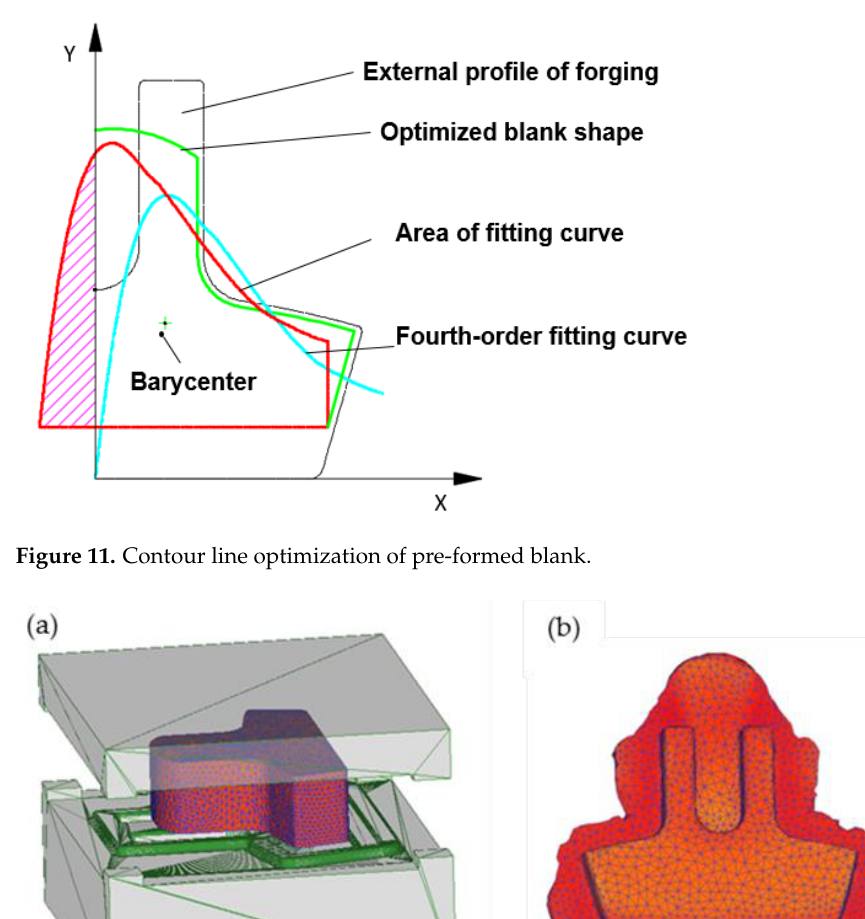
Figure 12. Numerical simulation diagram of final forging. ( a ) Optimized blank outline; ( b ) final forging drawing after simulation.